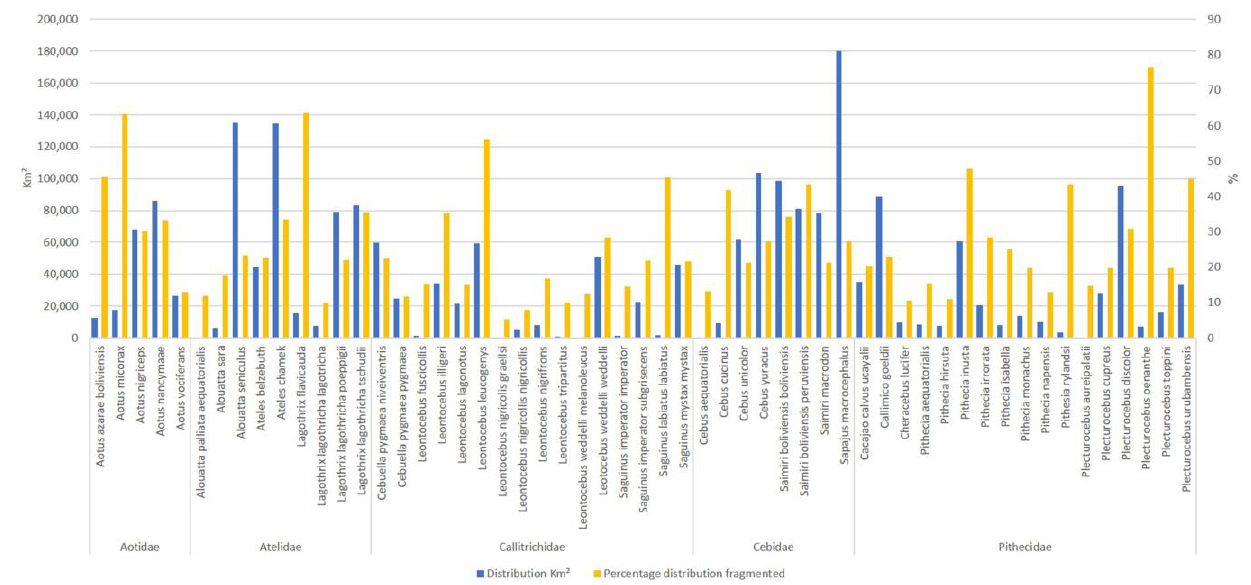
Figure 1. Estimated distribution size and percent distribution fragmented and/or deforested for Peruvian primate taxa (n = 55).